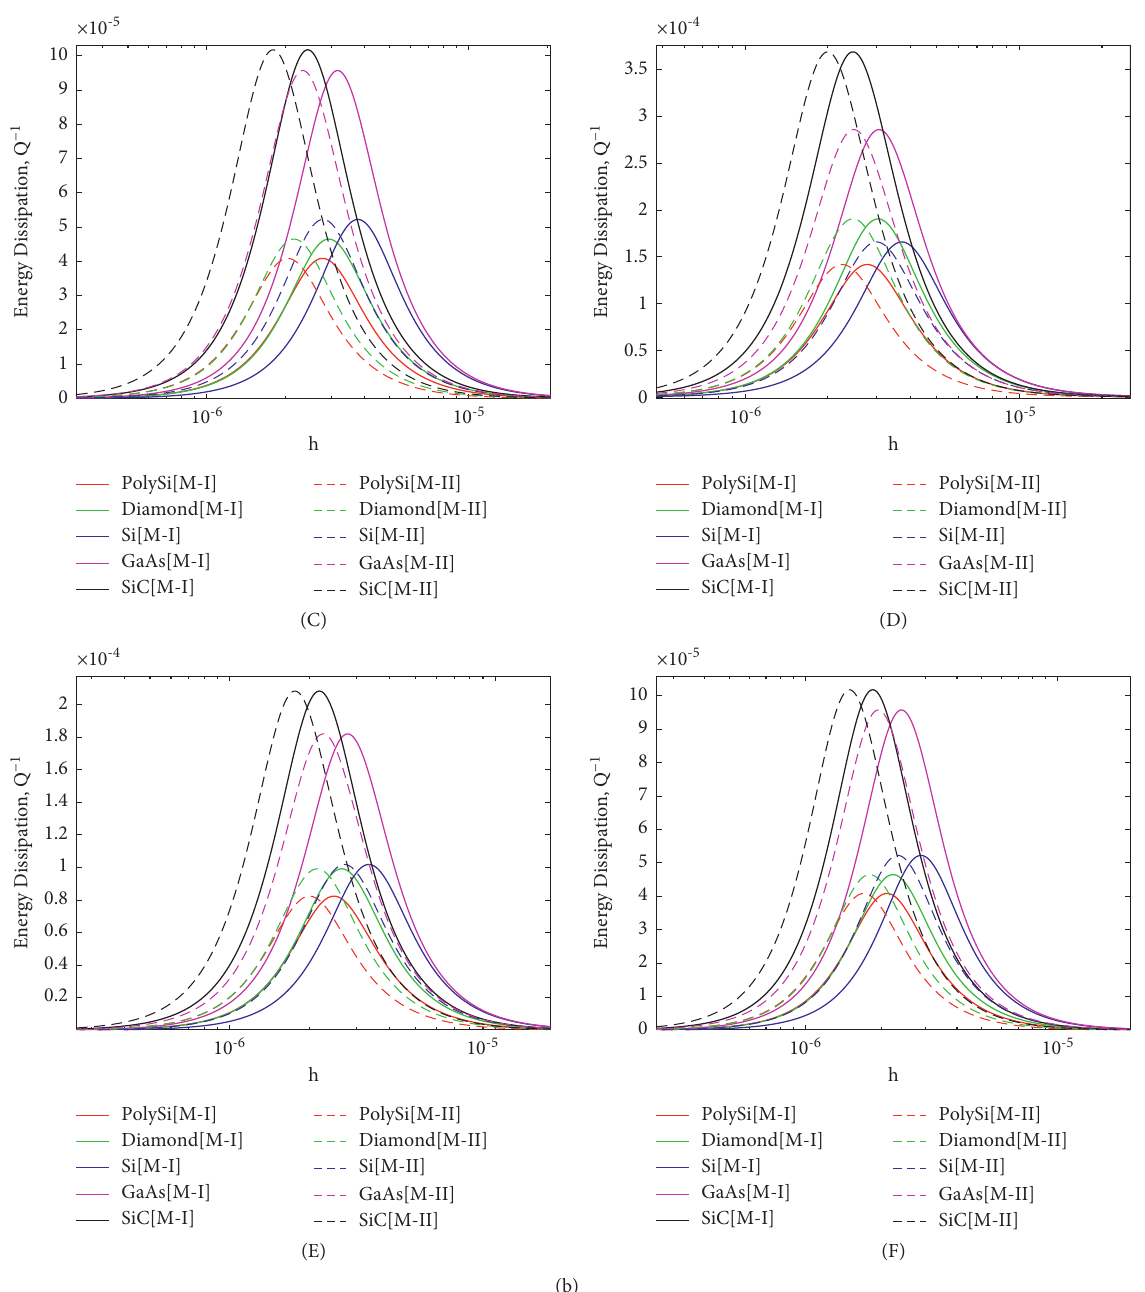
Figure 5: Comparison of energy dissipation, Q − 1 vs. thickness, h of a rectangular plate for two modes (mode I and mode II) with (a) simply supported boundary condition and varying l / h values: (A) l / h � 0, (B) l / h � 0.5, and (C) l / h � 1 and (b) clamped-clamped boundary condition and varying l/h values (D) l/h � 0, (E) l/h � 0.5, and (F) l/h �